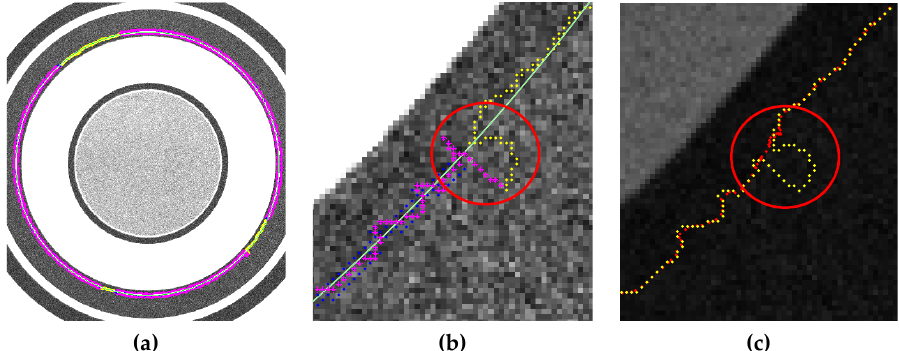
Figure 13. Arc-based edge connection, in which yellow dots are previous edges and magenta dots are arc-based connections. (a) Edge connection of 𝐼 1 ; (b) Edge connection of 𝐼 2 .